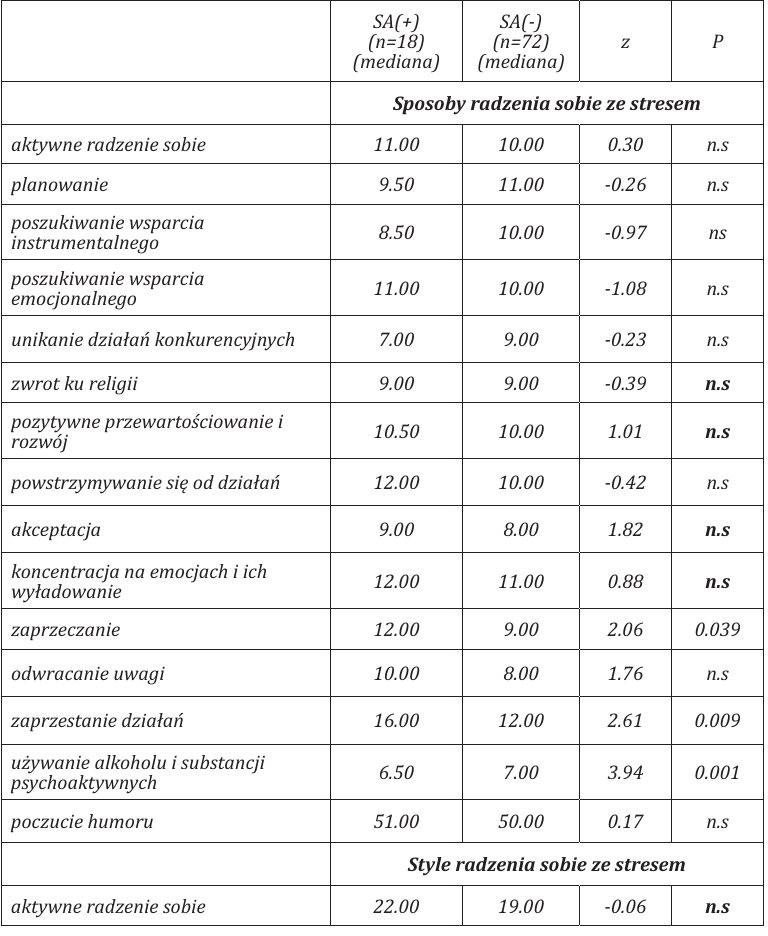
Tab.5 Porównanie wyników uzyskanych w kwestionariuszu COPE przez osoby uzależnione od alkoholu z próbami samobójczymi w wywiadzie i